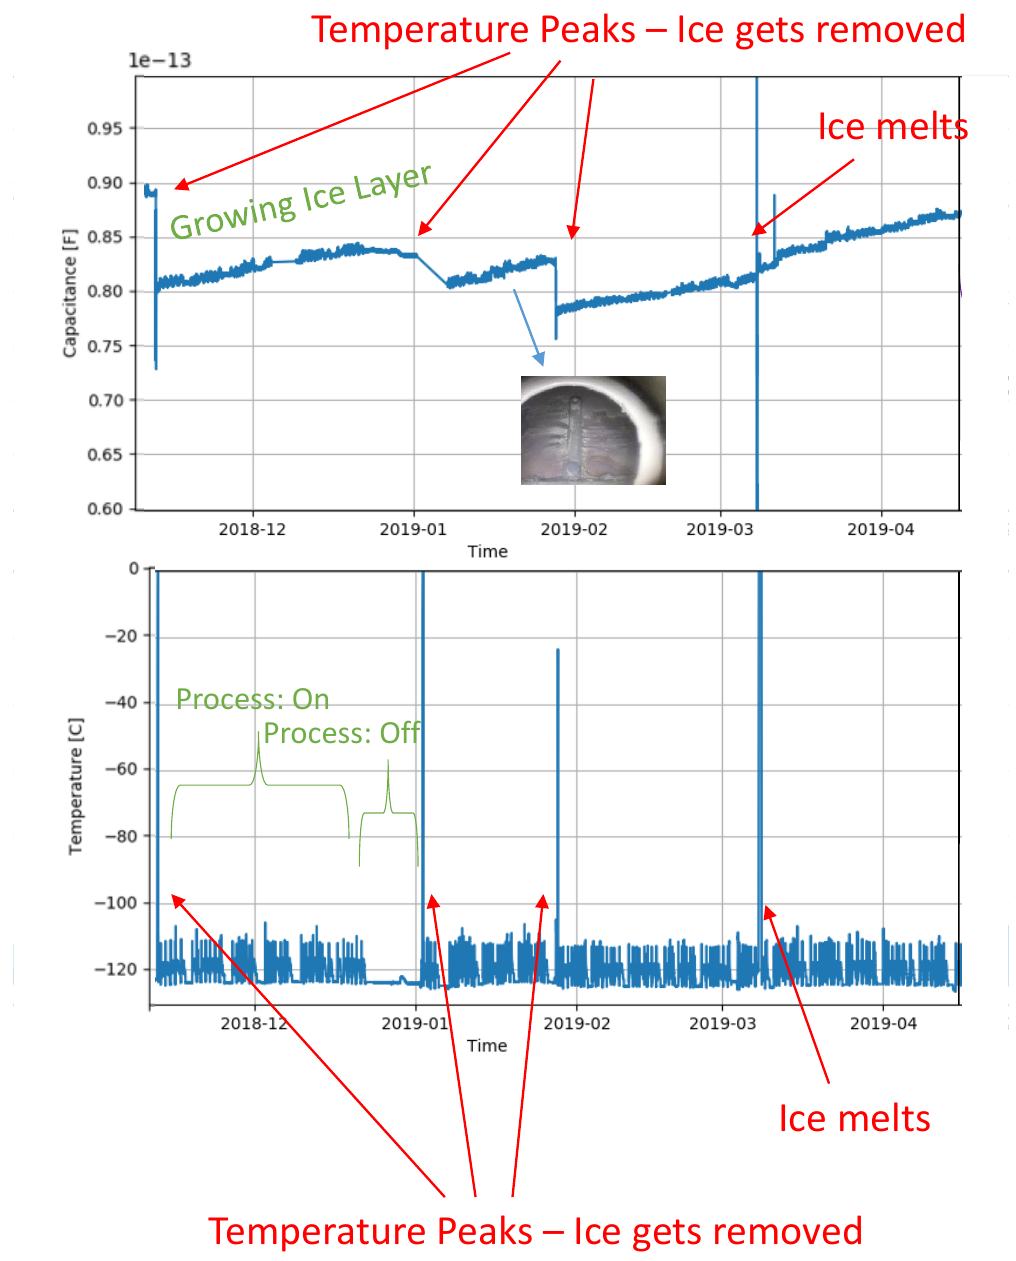
Figure 13. Capacitance and temperature measurement results over a long period of time showing the ice growth and also de-icing, which can be identified by the temperature peaks. To further show the long-term stability of the measurement system, Figure 14 illustrates the measurements received from one of the electrode channels which is not connected to an electrode. The second plot shows that the capacitance change due to variations in the environment around the electronics is negligible. To further state that the measurements are not significantly dependant on the humidity or temperature around the electronic parts, the first plot in the figure displays the measurements of an humidity sensor and a temperature sensor placed inside the electronics housing, which were installed to check for dependencies of the measurements on the environmental influences around the